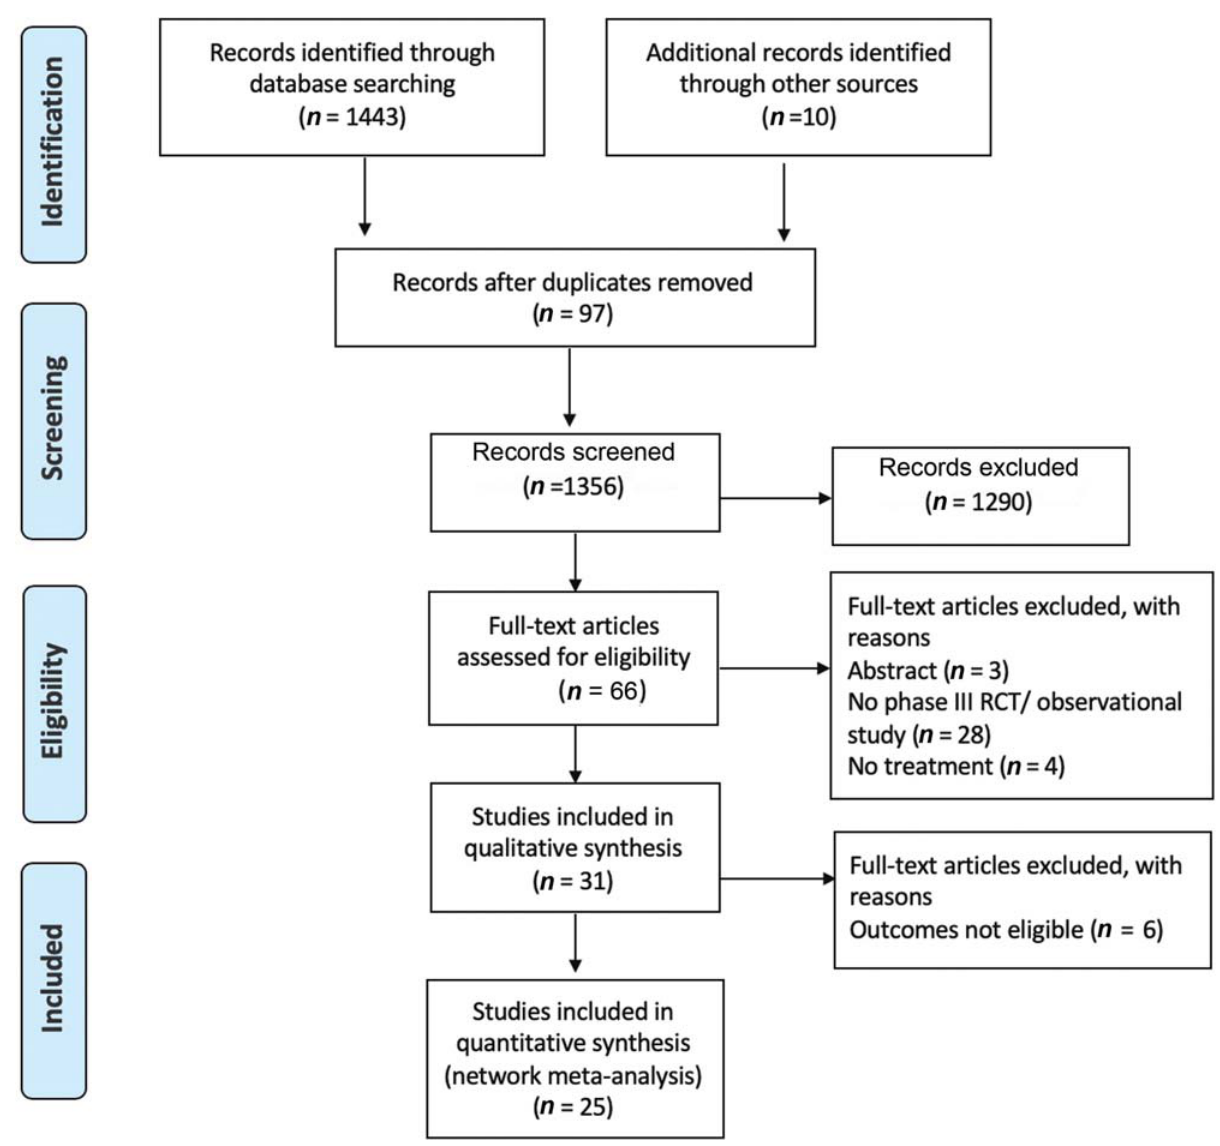
Fig. 1 PRISMA diagram. PRISMA, preferred reporting items for systematic reviews and